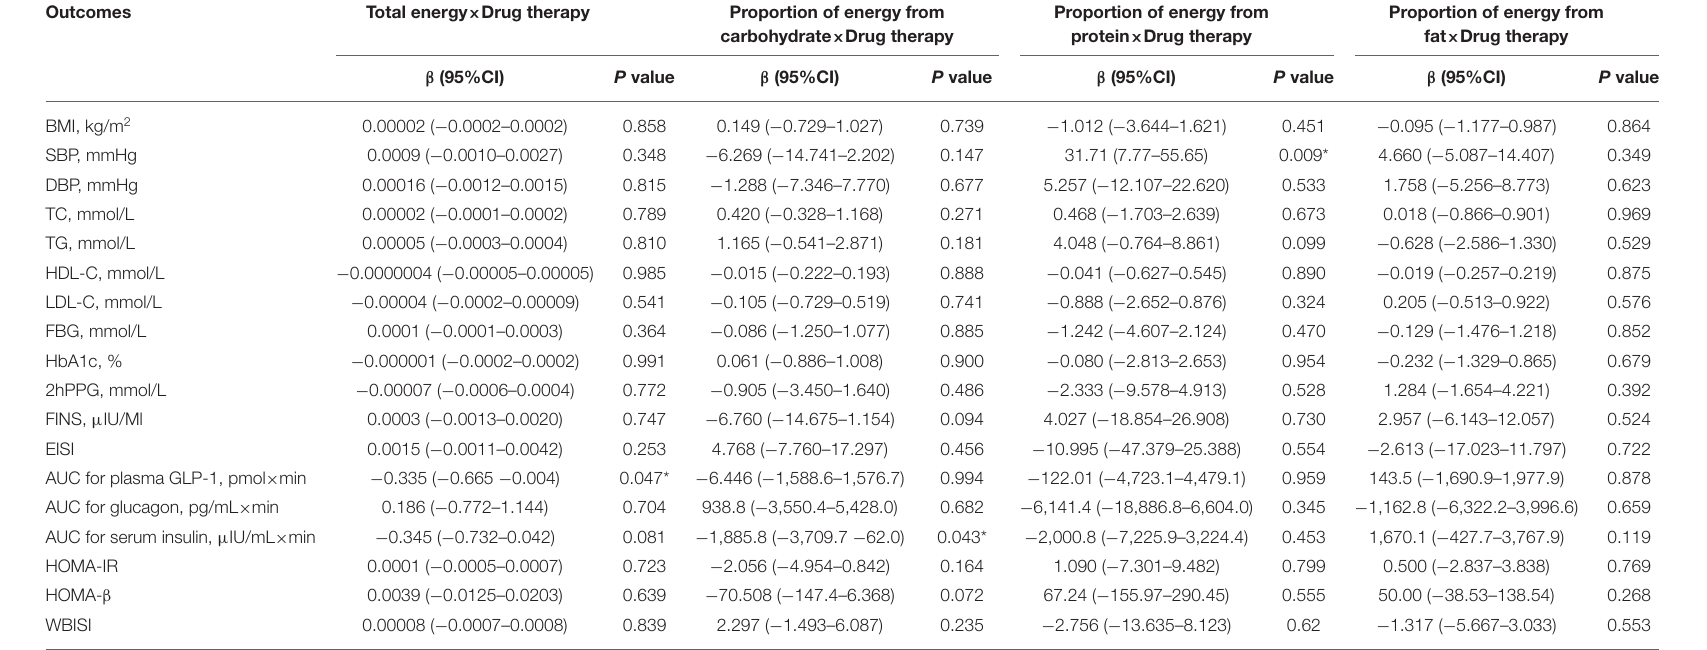
TABLE 4 | Diet-drug interaction on clinical outcomes in linear mixed-effect